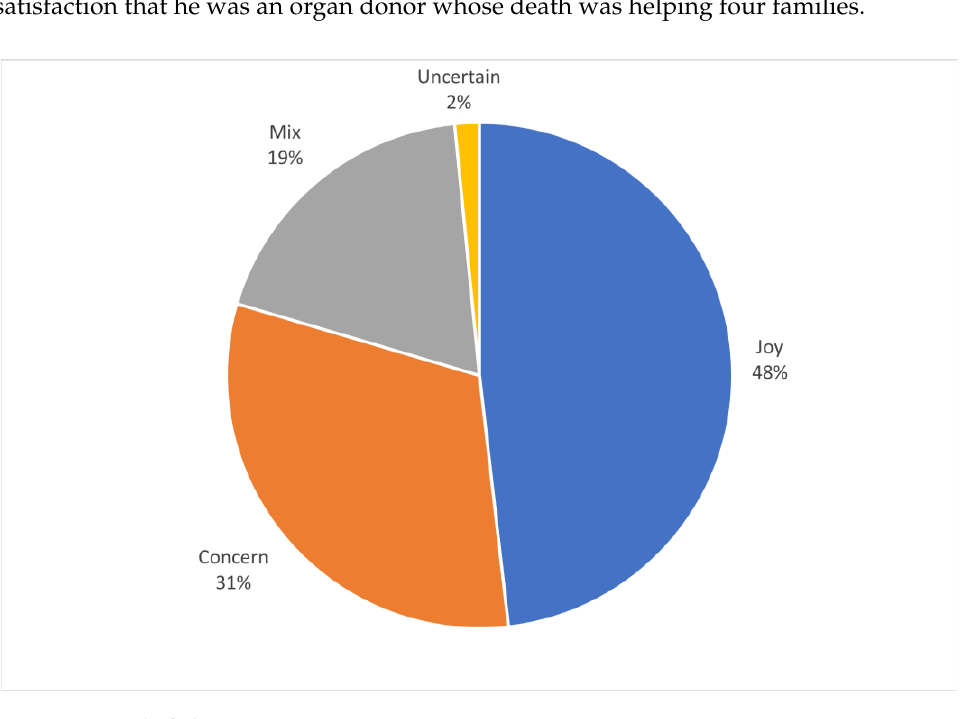
Figure 3. Mood of Sharing.